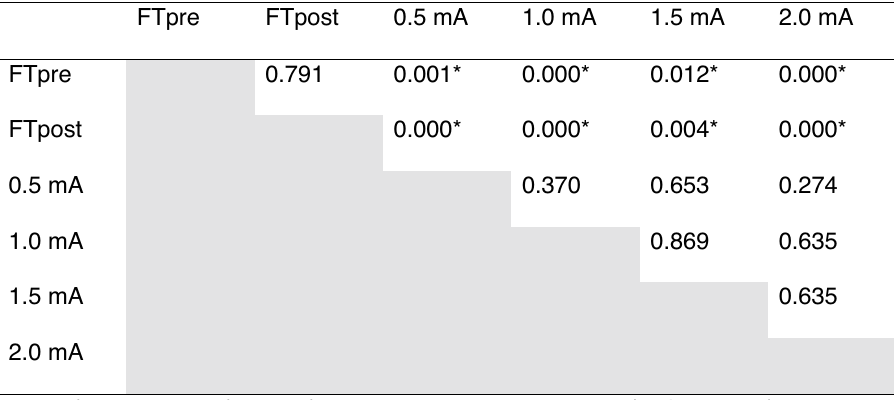
Pairwise comparisons between fingertapping and TDCS activation (M1-S1